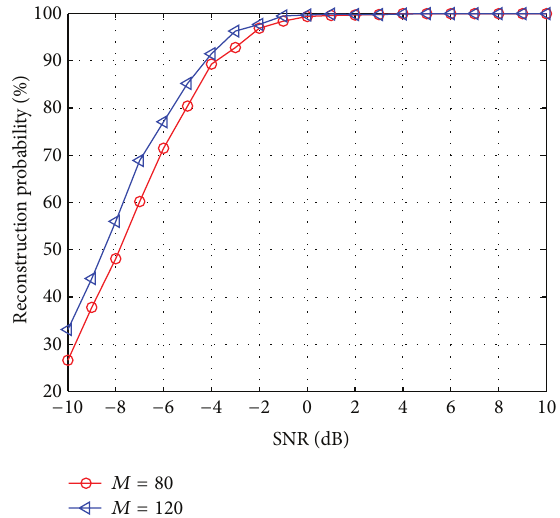
Figure 6: Reconstruction probability for single target under differ- ent SNR